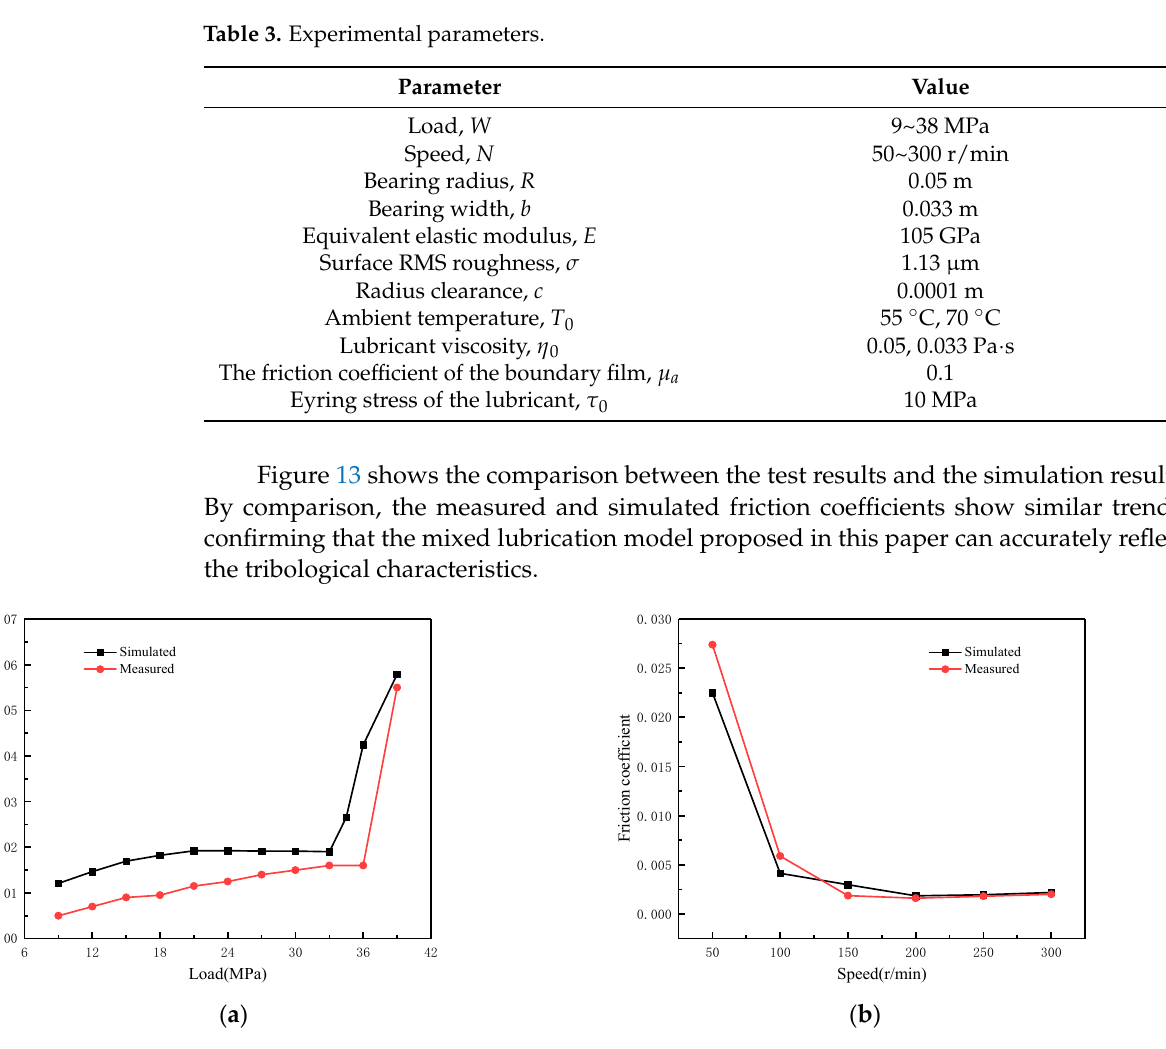
Table 3. Experimental parameters.